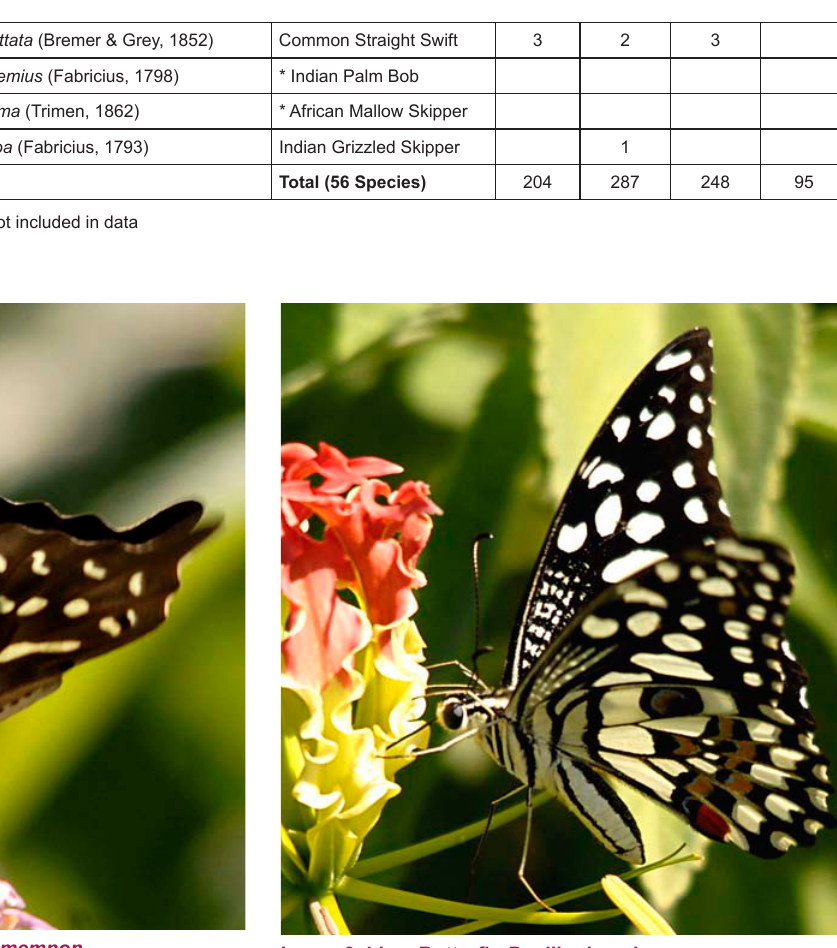
Image 2. Tailed Jay Graphium agamemnon Image 3. Lime Butterfly Papilio